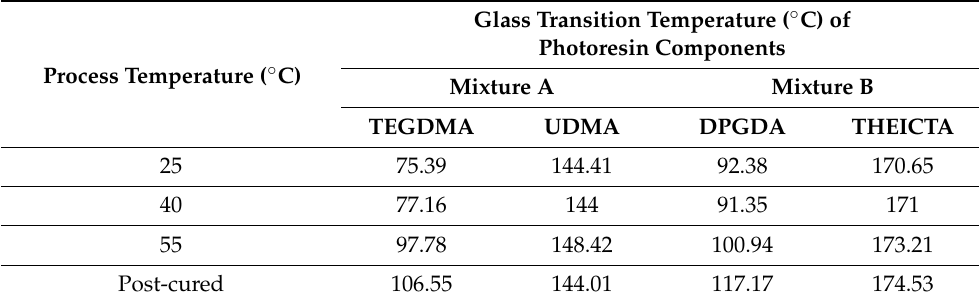
Table 5. The T g associated with the structural and diluent components of the two photoresins at different process temperatures and in their post-cured